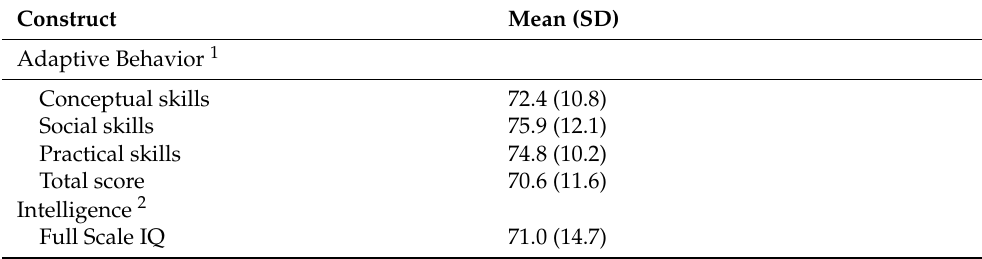
Table 1. Mean scores and standard deviations on the tests of adaptive behavior and